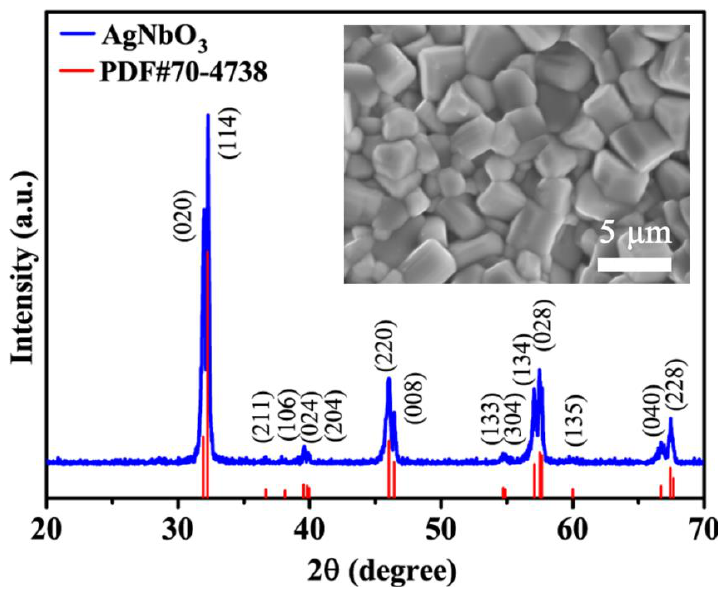
Figure 1. XRD pattern of the sintered AgNbO 3 ceramics. The inset shows SEM morphology images of the AgNbO 3